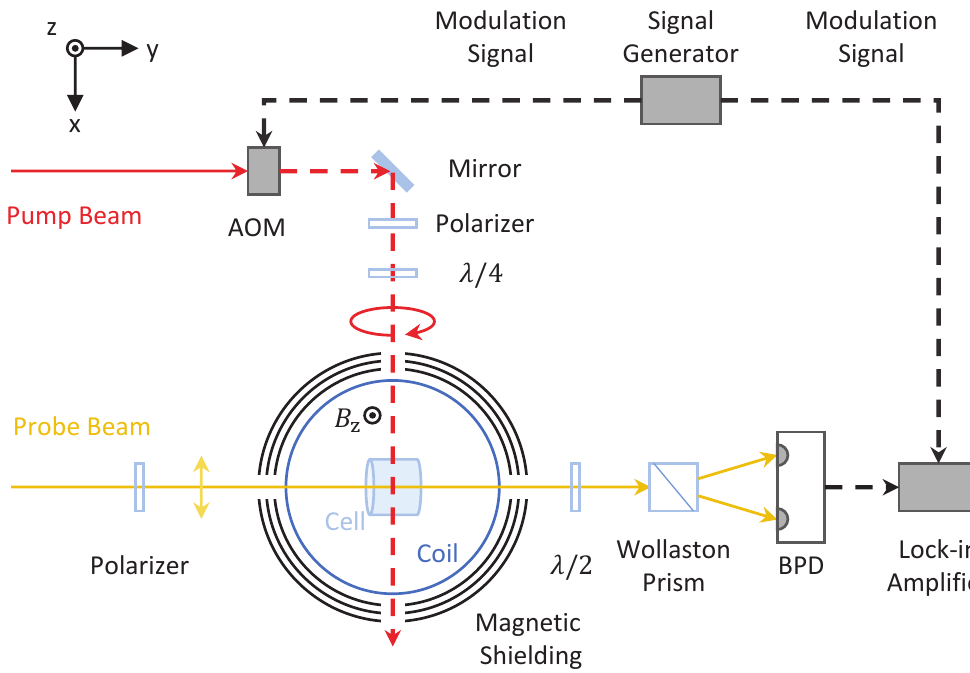
Figure 1. Schematics of the Bell–Bloom optically pumped magnetometers (OPM). Cell: cylindrical paraffin-coated cesium vapor cell; AOM: acoustic-optical modulator; λ /4: quarter-wave plate; λ /2: half-wave plate; BPD: balanced photodetector. The cesium atoms are confined in the cylindrical paraffin-coated cesium vapor cell which is placed inside a seven-layer magnetic shielding. The biasing magnetic field is set along the axial direction of the magnetic shield, i.e., the z -axis. The atoms are optically pumped with a circularly polarized and amplitude modulated D1 laser beam, and the precessing atomic spins are probed with a linearly polarized D2 laser beam. The Faraday rotation of the probe beam is analyzed with a polarimeter which is composed of a half-wave plate, a Wollaston prism, and a balanced photodetector shown on the right side of the magnetic shielding. The detected Faraday rotation signal from the polarimeter is demodulated with a lock-in amplifier. A signal generator is used to generate the modulation signal applied to the AOM and to provide the reference signal to the lock-in amplifier for